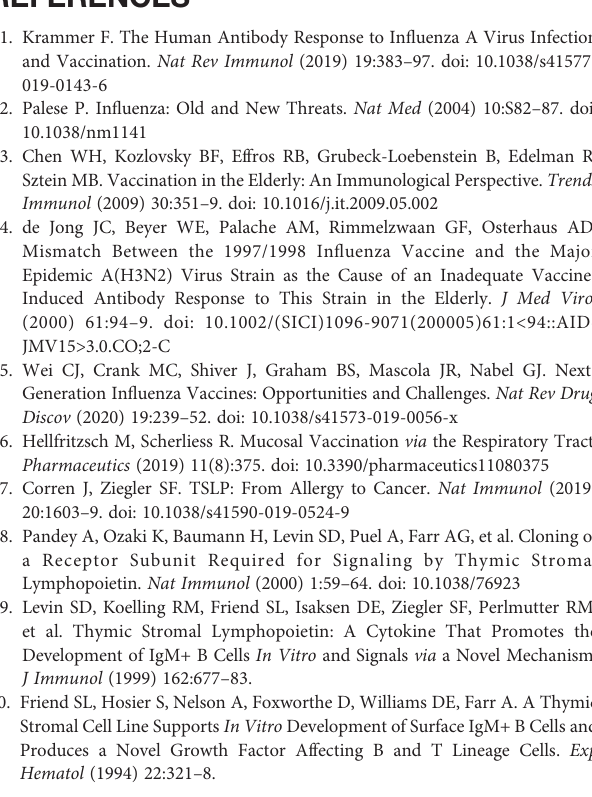
Supplementary Figure 1 | In fl uenza virus susceptibility of naïve Tslpr-/- and WT mice is comparable. Naive B6-WT (n = 6) and Tslpr – / – mice (n = 6) were intranasally